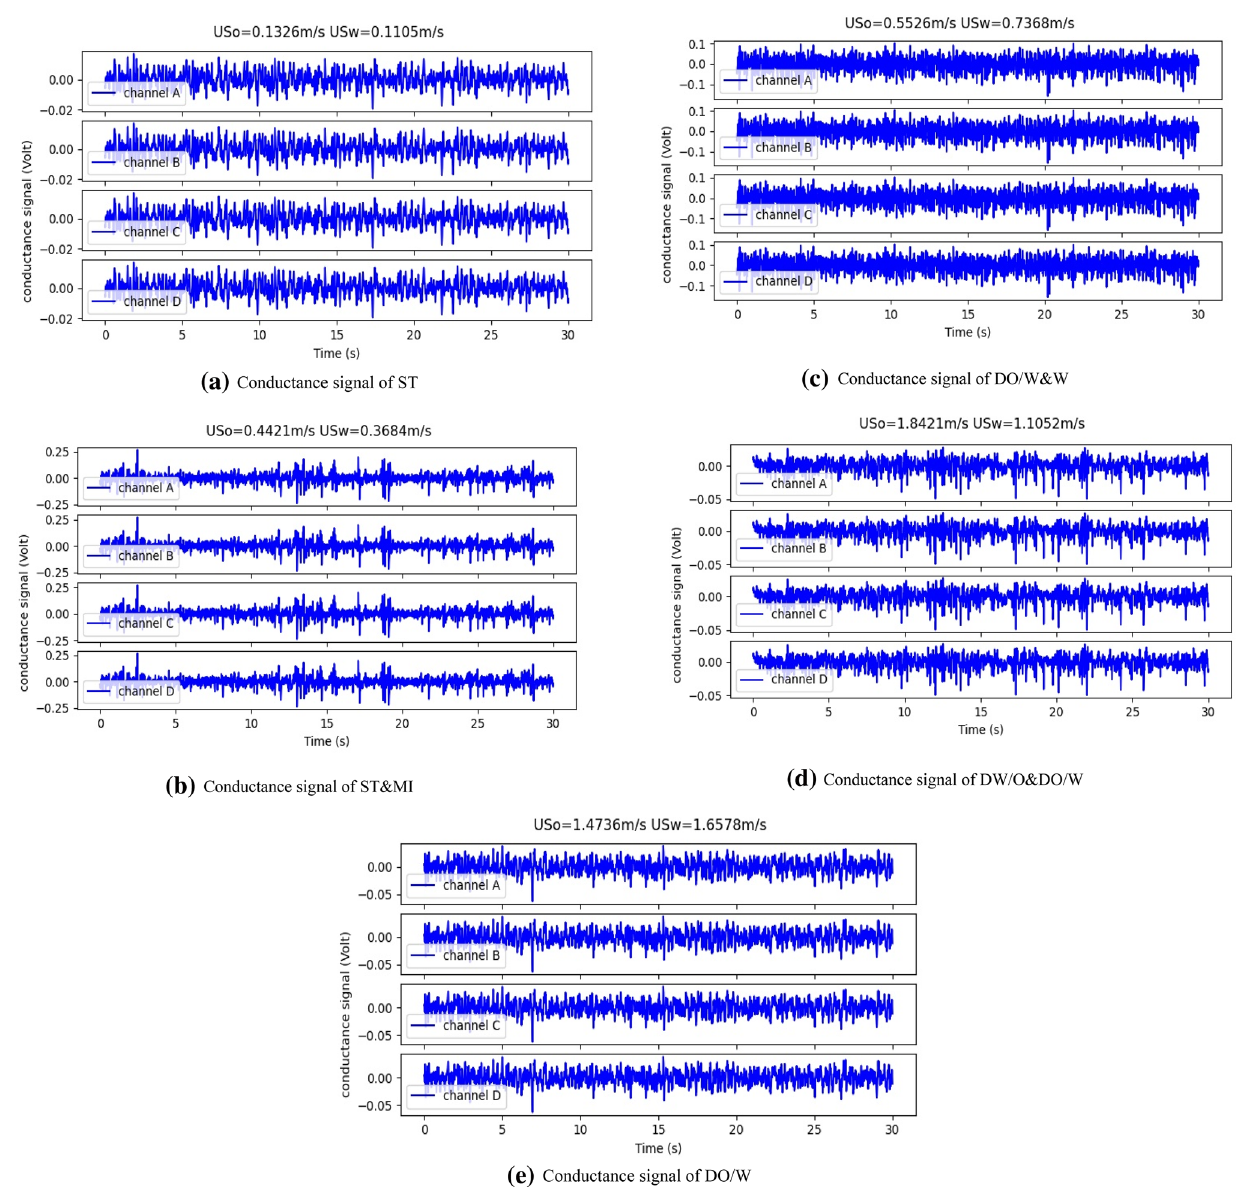
Fig. 4 Four-electrode conductivity signals for five typical flow